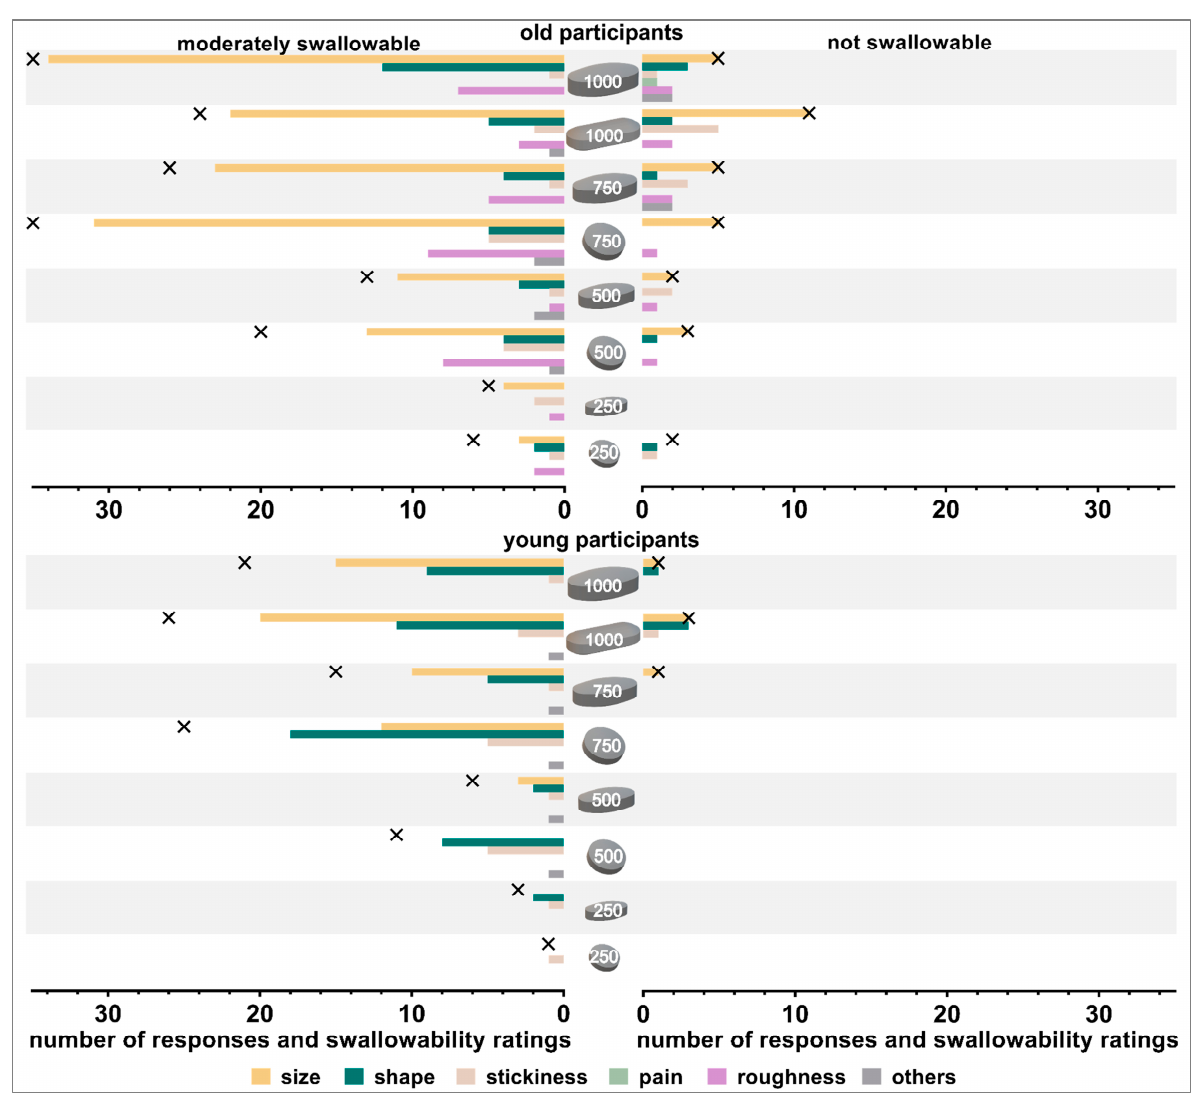
Figure 7. Number of responses and swallowability ratings ( moderately swallowable shown on left panels and not swallowable shown on right panels). Crosses indicate the number of swallowability ratings (absolute numbers). Data are shown separately for old participants (upper panel) and young participants (lower panel).